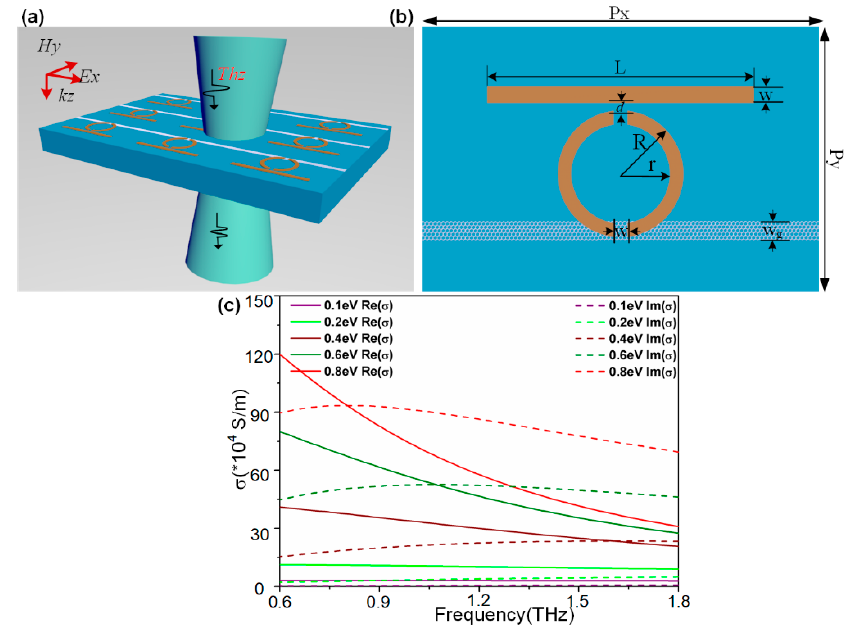
Figure 1. ( a ) Schematic of the proposed PIT metasurface with polarization configuration of incident light. ( b ) Geometrical description of a unit cell: Px = 120 µm, Py = 80 µm, L = 80 µm, W = 5 µm, r 1 = 23 µm, r 2 = 18 µm, d = 3 µm, W g = 7 µm, and △ h = 0 µm ( △ h: vertical distance of split gap, not shown in figure). ( c ) Real and imaginary parts of the graphene conductivity with the Fermi level increasing from 0.1 eV to 0.8 eV.